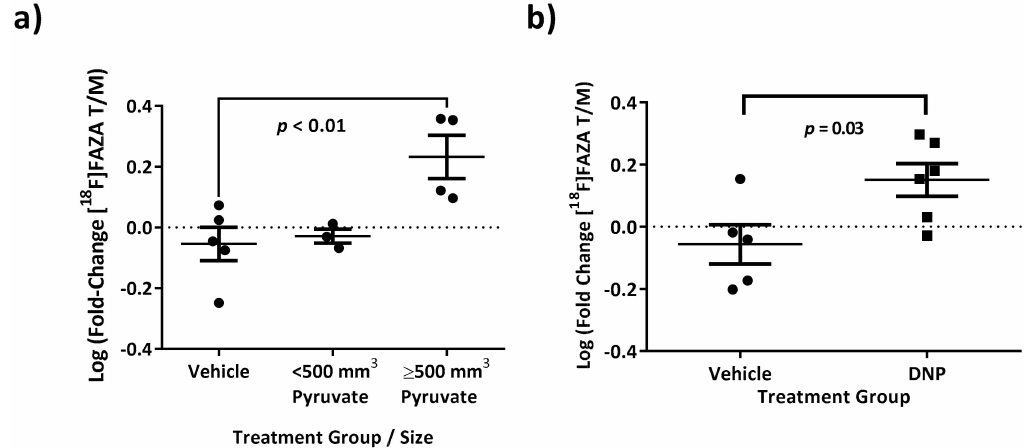
Figure 5. [ 18 F]FAZA retention could be enhanced by small molecule interventions that increase